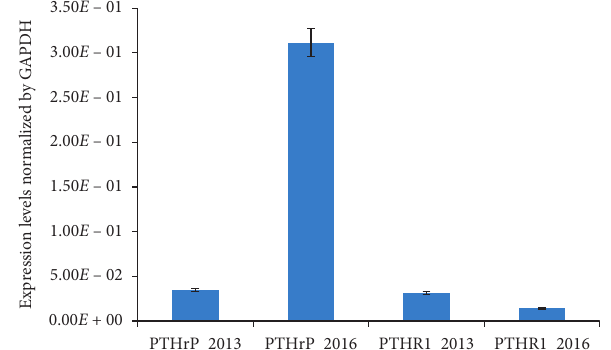
Figure 2: The mRNA expression of PTHrP and its receptor PTHR1 in the lymph nodes. The PTHrP levels increased, while PTHR1 levels have decreased in 2016 compared to 2013. The mRNA was extracted from formalin-fixed paraffin-embedded lymph node tissue collected in 2013 and 2016. The expression levels of PTHrT and PTHR1 were normalized using GAPDH expression levels. Each bar represents a mean of three independent experiments for one cell line; bars represent